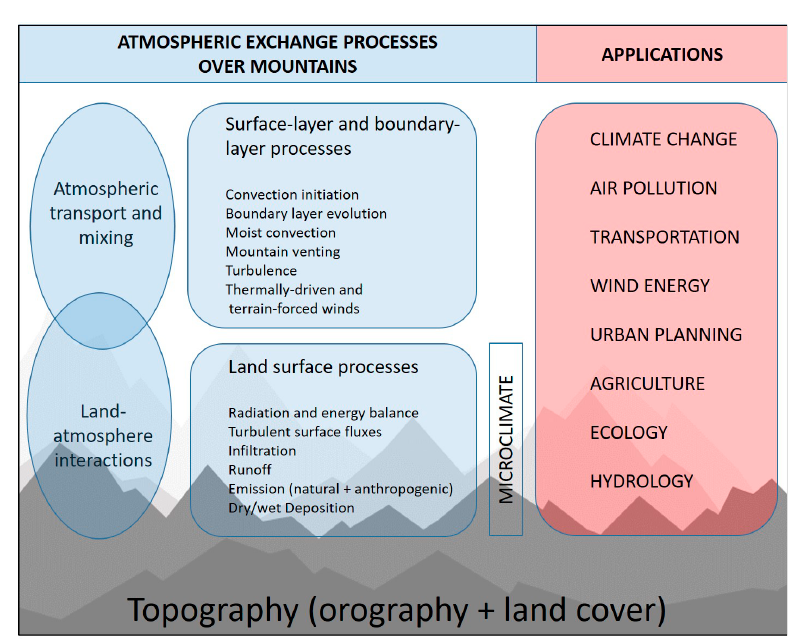
Figure 1. Atmospheric exchange processes consist of land-atmosphere interactions and atmospheric transport and mixing (blue ovals). These processes can be subdivided into land-surface, surface-layer, and boundary-layer processes (blue rectangles) that are relevant in meteorological applications in many scientific disciplines and sectors of the economy. The disciplines and sectors discussed in this paper, referred to here as ‘applications’, are listed in the right column (red rectangle).